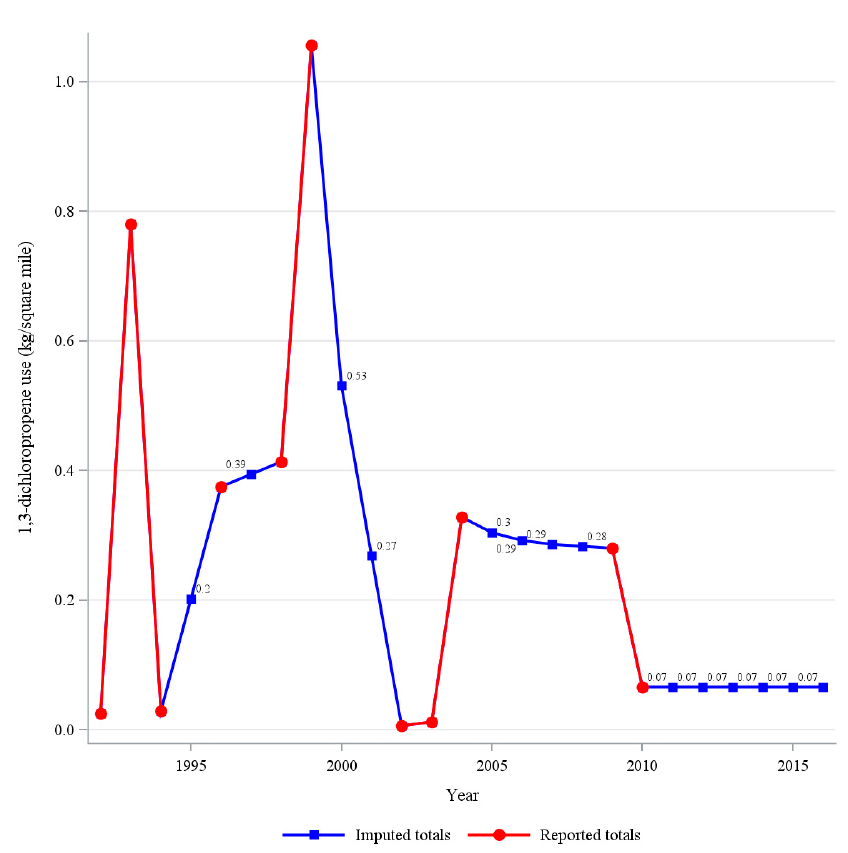
Figure 1. Reported and imputed values of 1,3-dichloropropene for Pennsylvania.